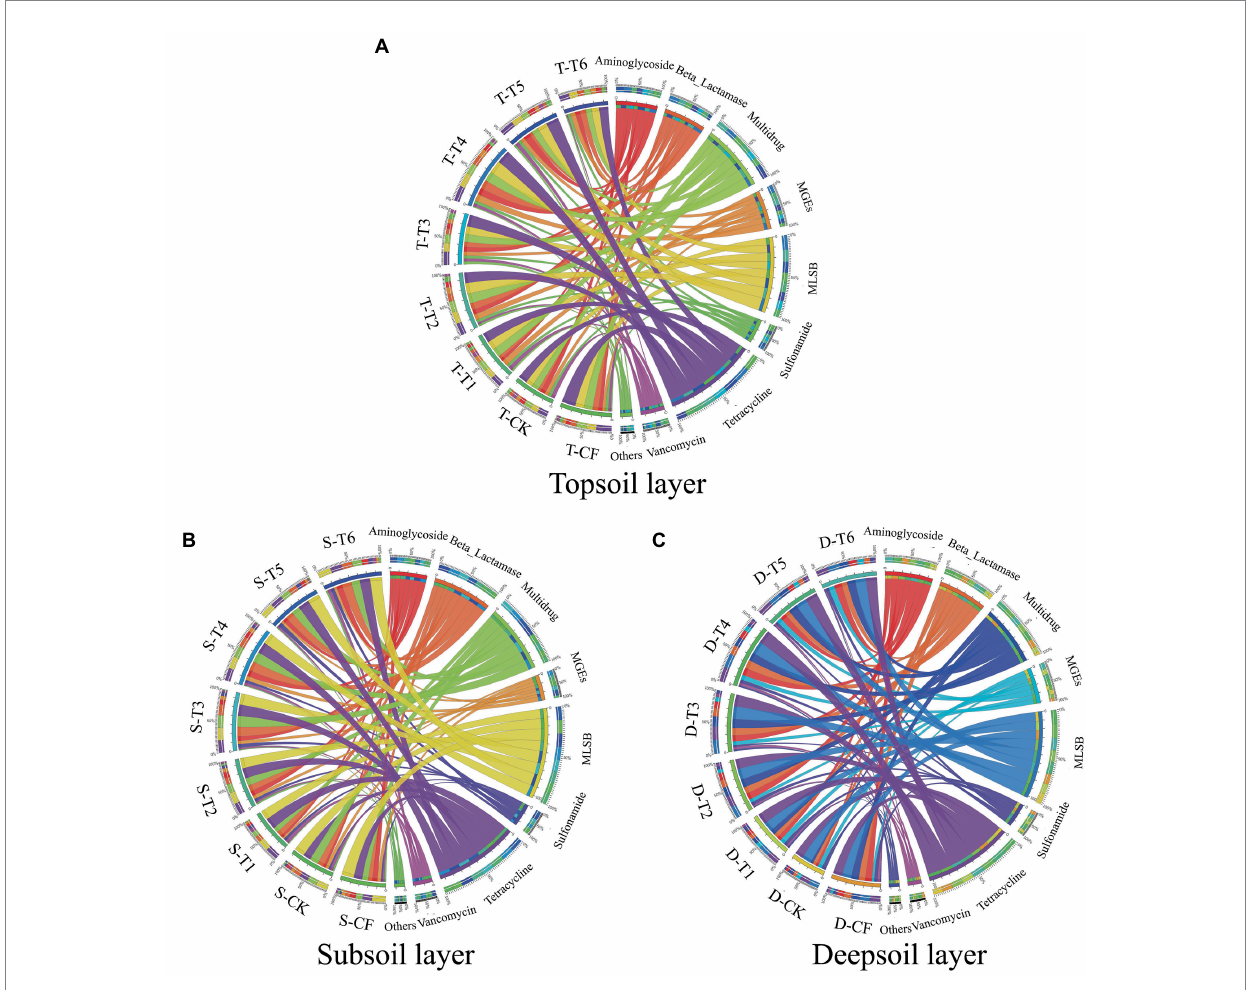
FIGURE 2 Distribution of each class of ARGs in paddy-upland rotation soil with different fertilization modes and different depths, (A) showing 0–20 cm in the topsoil, (B) showing 20–50 cm in the subsoil, and (C) showing 50–80 cm in the deepsoil. Please refer to Figure 1 for fertilization treatment